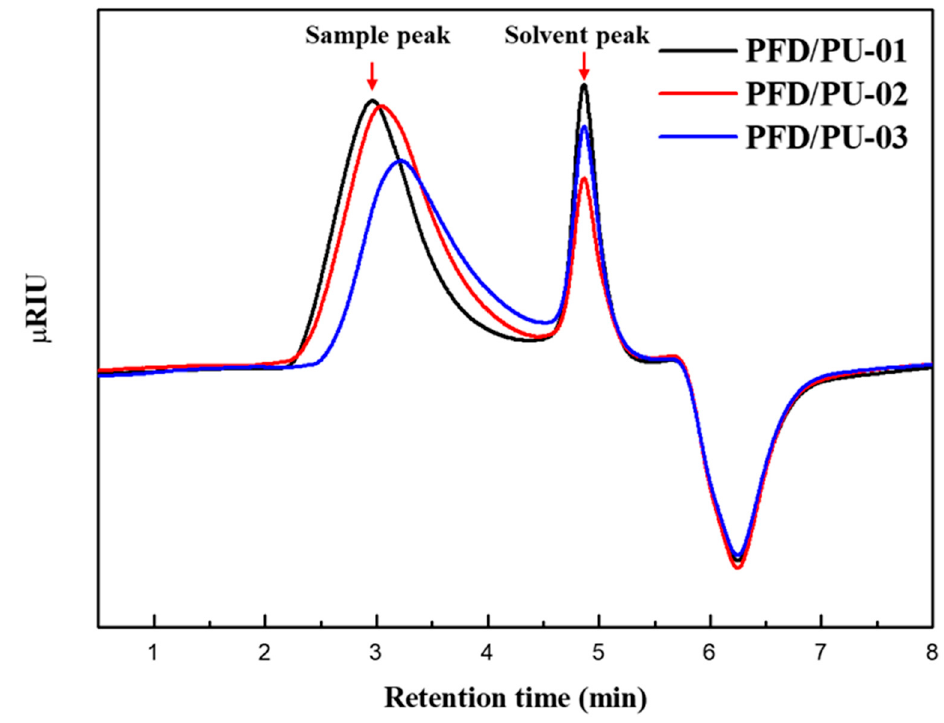
Figure 1. GPC curves of PFD/PUs.